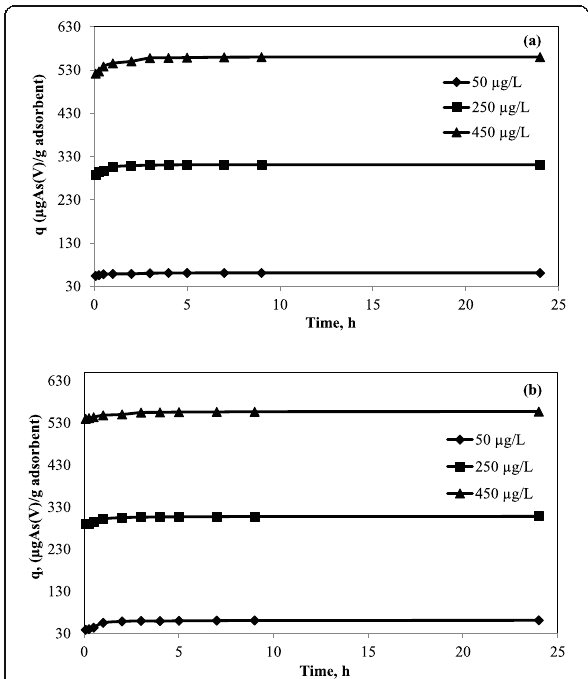
Fig. 6 Arsenate adsorption onto a GOFeZA and b GOFeZB as a function of time for varying initial arsenate concentration